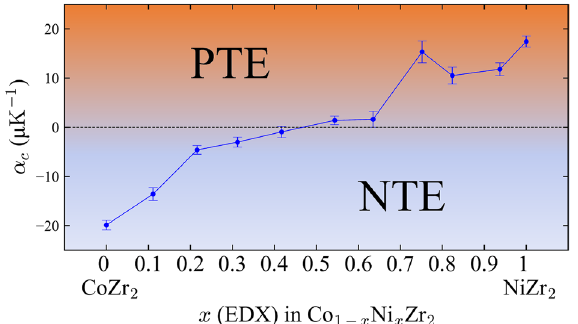
Figure 3. Ni concentration ( x ) dependence of α c for Co 1− x Ni x Zr 2 .